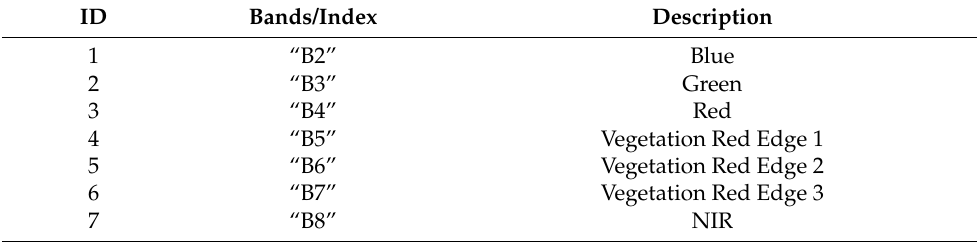
Table 3. S2 input